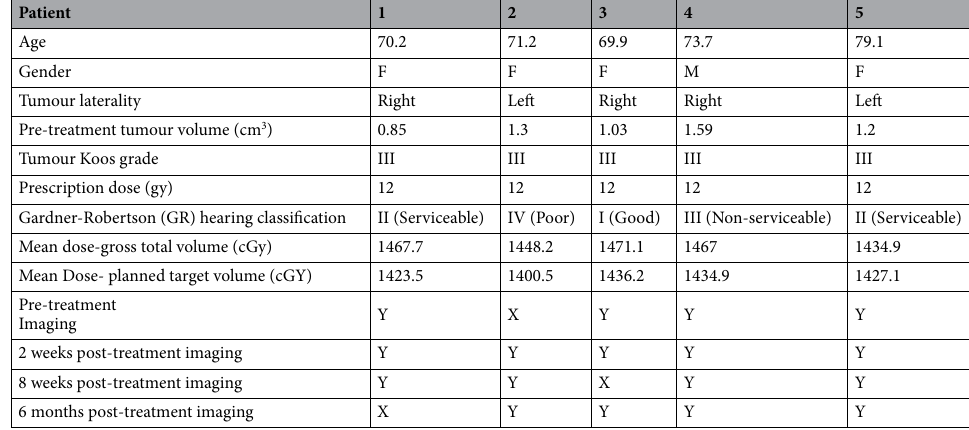
Table 1. Clinical features, delivered radiation dose and details of when each patient underwent the research MRI protocol. a Age at time of SRS